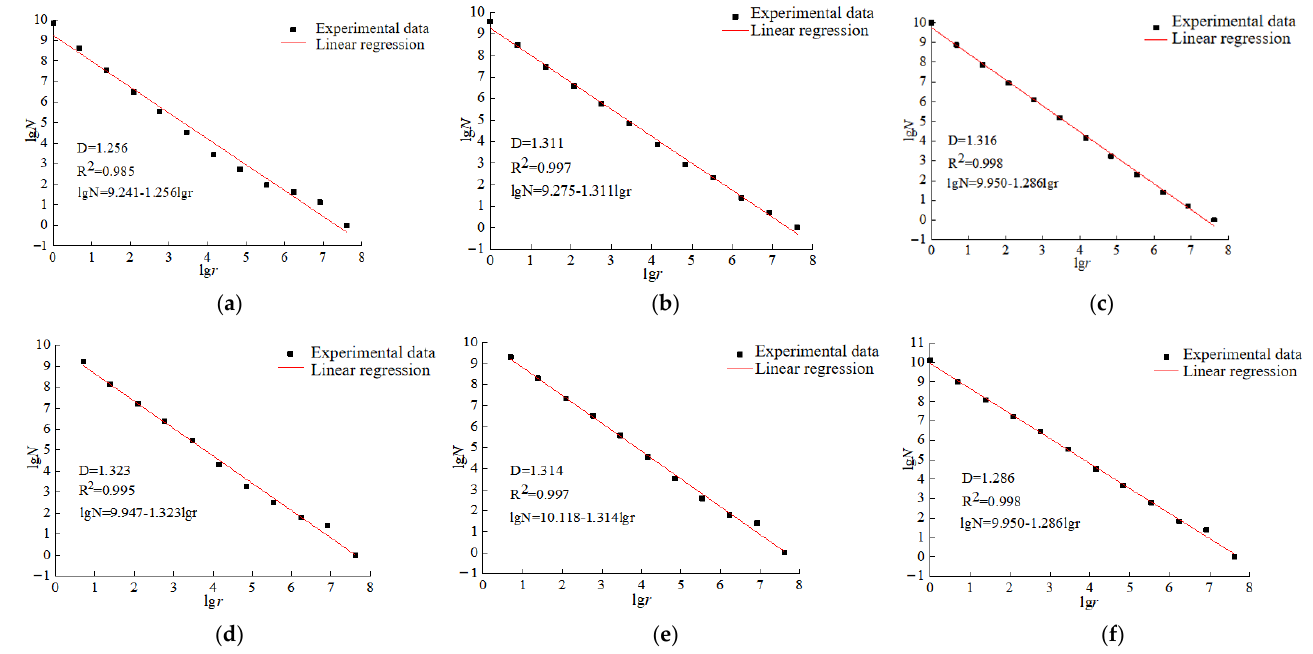
Figure 10. Bilogarithmic curves of mining-induced fissure network with different advancing de- grees. ( a ) Advancing distance 87 m; ( b ) Advancing distance 107 m; ( c ) Advancing distance 127 m; ( d ) Advancing distance 138 m; ( e ) Advancing distance 156 m; ( f ) Advancing distance 185 m.